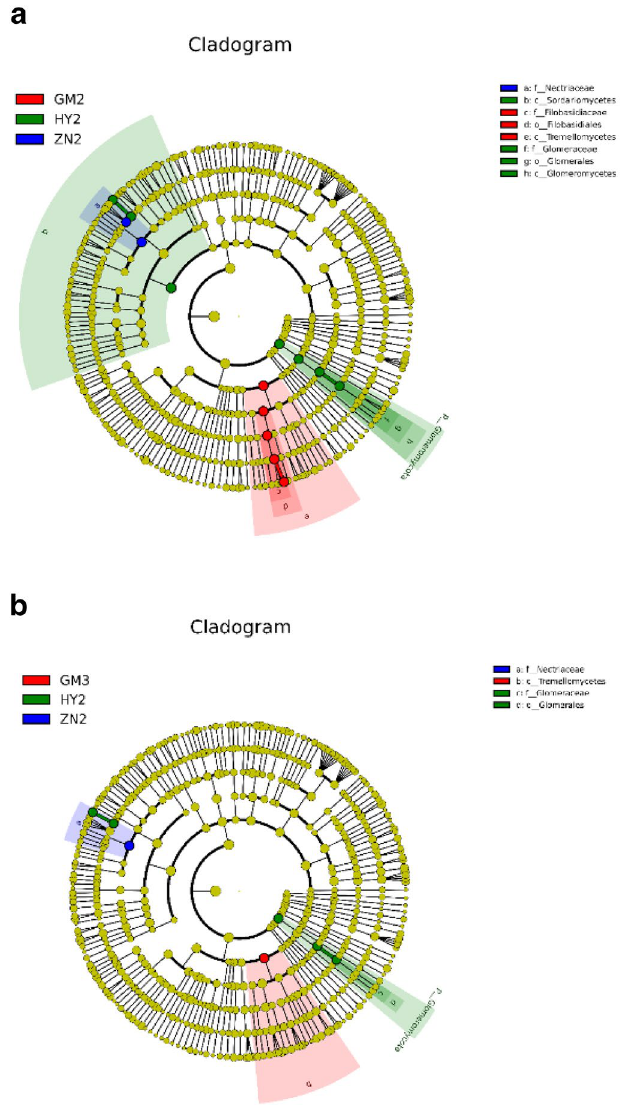
Figure 7. ( a ) Cladogram of LEfSe analysis. ( b ) Cladogram of LEfSe